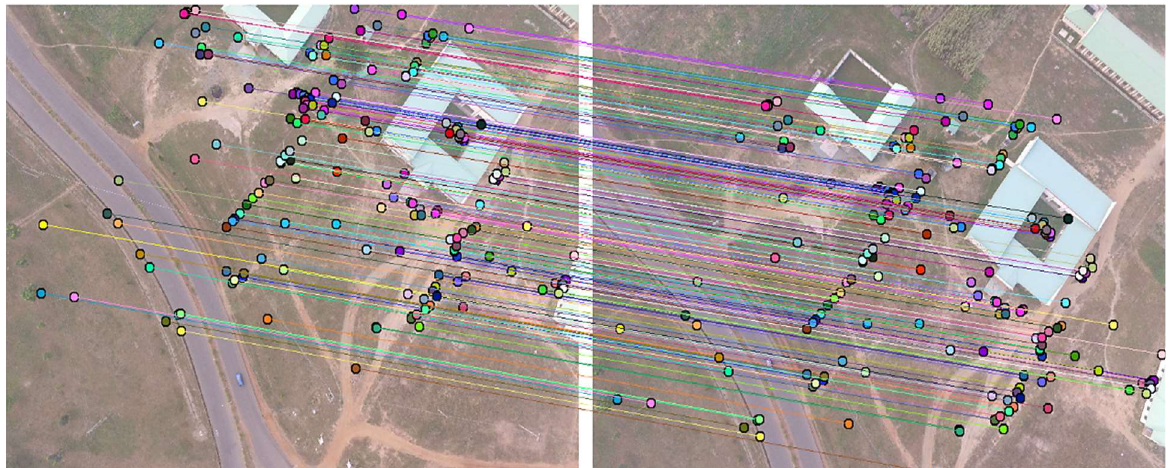
Figure 5a: Matched inliers using Modified Harries Corner Detector (MHCD)